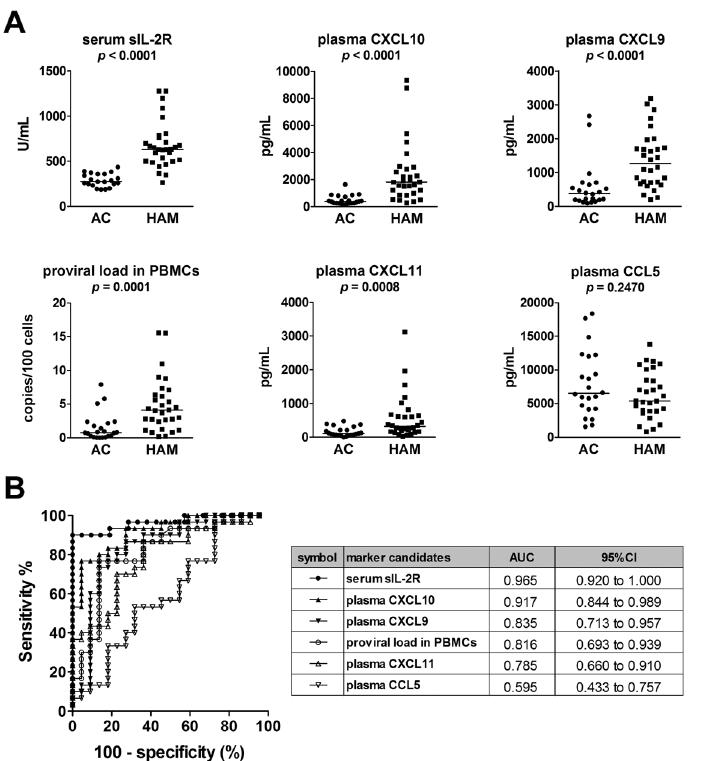
Figure 1. Selection of candidate biomarkers in the blood by comparing HAM/TSP patients and asymptomatic carriers. ( A ) Serum levels of soluble IL-2 receptor (sIL-2R), proviral loads in peripheral blood mononuclear cells (PBMCs), and plasma levels of four chemokines (chemokine (C-X-C motif) ligand (CXCL) 9, CXCL10, CXC11, and chemokine (C-C motif) ligand (CCL) 5) were compared between HAM/TSP patients (HAM; n=30) and asymptomatic carriers (AC; n=22). Horizontal bars indicate the median values. The Mann-Whitney U -test was used for statistical analysis. ( B ) Receiver operating characteristic (ROC) analysis was employed to assess the sensitivities and specificities of the six markers exhibited in part (A) for discriminating HAM/TSP patients from ACs: greater proximity of the ROC curve to the upper left corner indicates higher sensitivity and specificity of the marker. AUC=area under the ROC curve; 95% CI=95% confidence interval.